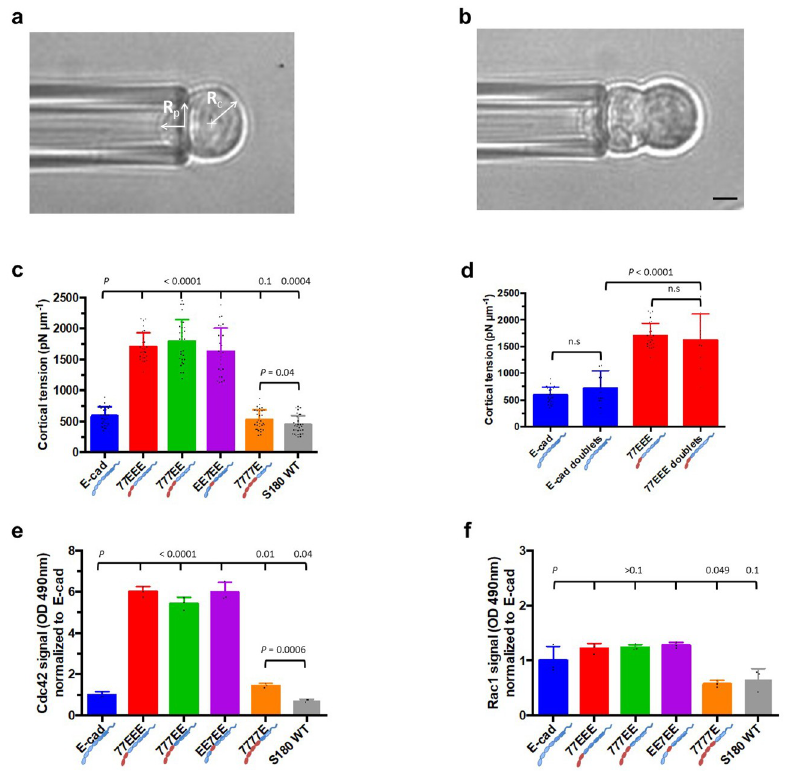
Fig 3. Cell cortical tension and Rho GTPase activity. (a) Bright-field image of a single cell held at the pipette by reducing the pressure inside the pipette such that the length of protrusion of the cell inside the pipette is equal to the radius of the pipette R p . R c is the radius of the cell. Scale bar, 5 μ m. (b) Bright-field image of a cell doublet held at the pipette by reducing the pressure inside the pipette such that the length of protrusion of the cell inside the pipette is equal to the radius of the pipette R p . Scale bar, 5 μ m. (c) Histogram of cortical tension values of cells from all groups and the parental S180 wild-type (WT) cells with no endogenous cadherins. Note that cortical tensions of E-cad- and 7777E-expressing cells are significantly higher than that of parental S180 WT cells; cortical tensions of 77EEE-, 777EE- and EE7EE-expressing cells are about three times higher than the parental S180 WT cells. (E-cad, n = 28; 77EEE, n = 27; 777EE, n = 29; EE7EE, n = 26; 7777E, n = 31; S180 WT, n = 31). (d) Histogram comparing cortical tension of single cells and doublets of E-cad- and 77EEE-expressing cells. Following the trend of single cells, the cortical